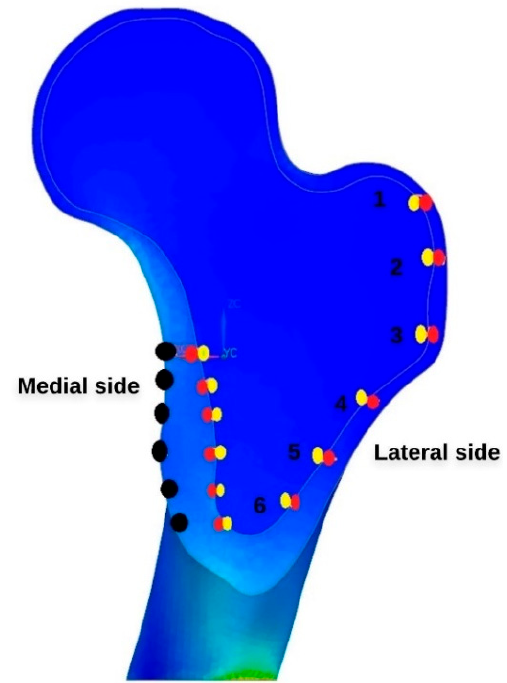
Figure 5. View of the proximal femur with the control points on the medial and lateral side.